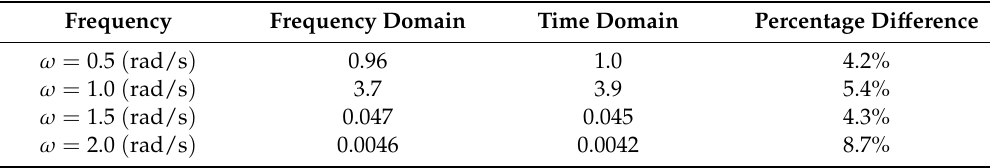
Table 2. The comparison between the motion response results of the frequency domain and time domain